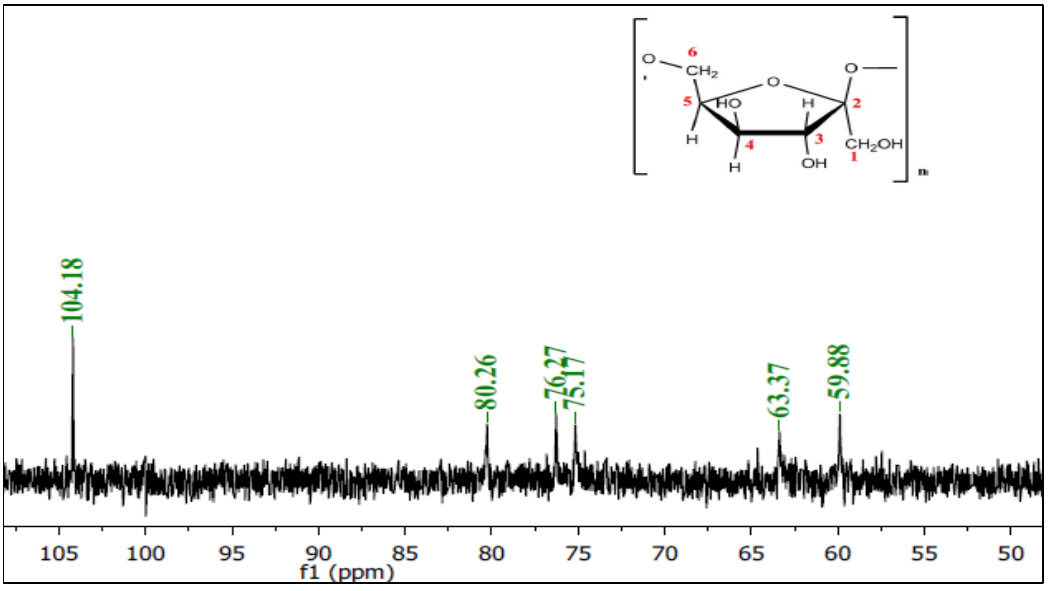
Figure 4. 13 C NMR spectrum of levan from Bacillus subtilis strain MZ292983.1. The recorded spec- trum was at 100 MHz for the sample in D 2 O. was at 100 MHz for the sample in D 2 O.